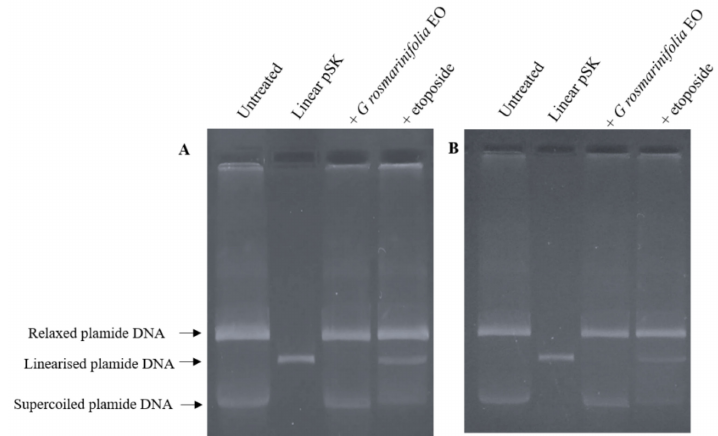
Figure 3. Plasmid DNA linearization assay. Nuclear extracts from untreated cells, HL-60 ( A ) and HL-60R ( B ), were incubated with EO (at the corresponding IC 50 values) or with etoposide (60 µ g/mL) and the supercoiled pSK plasmid DNA. Etoposide was used as a control capable of stabilizing the cleavable complex. Linear pSK DNA produced by the action of the restriction enzyme Pst I acting on a single site on the plasmide. The panels show a representative experiment of three independent experiments.